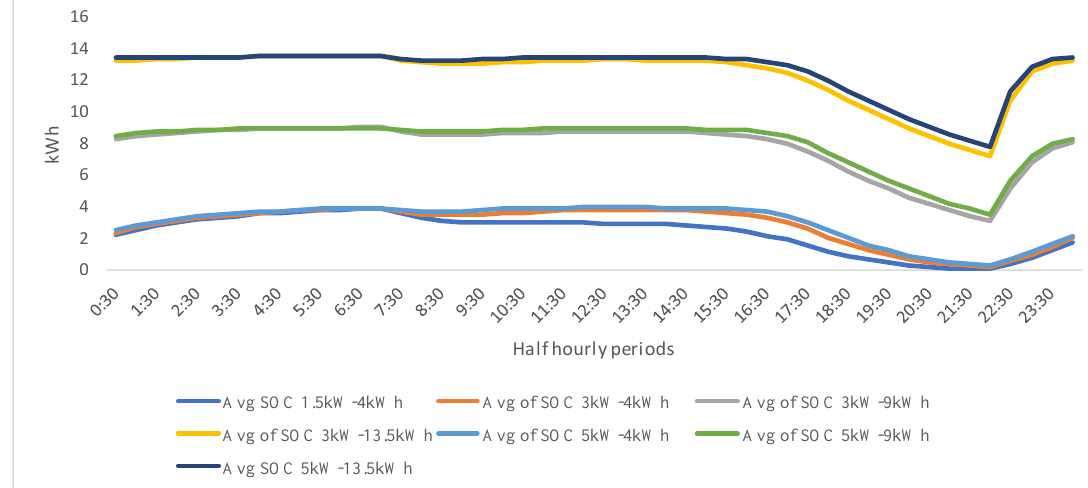
Figure 11. BESS average SOC per period (kWh).